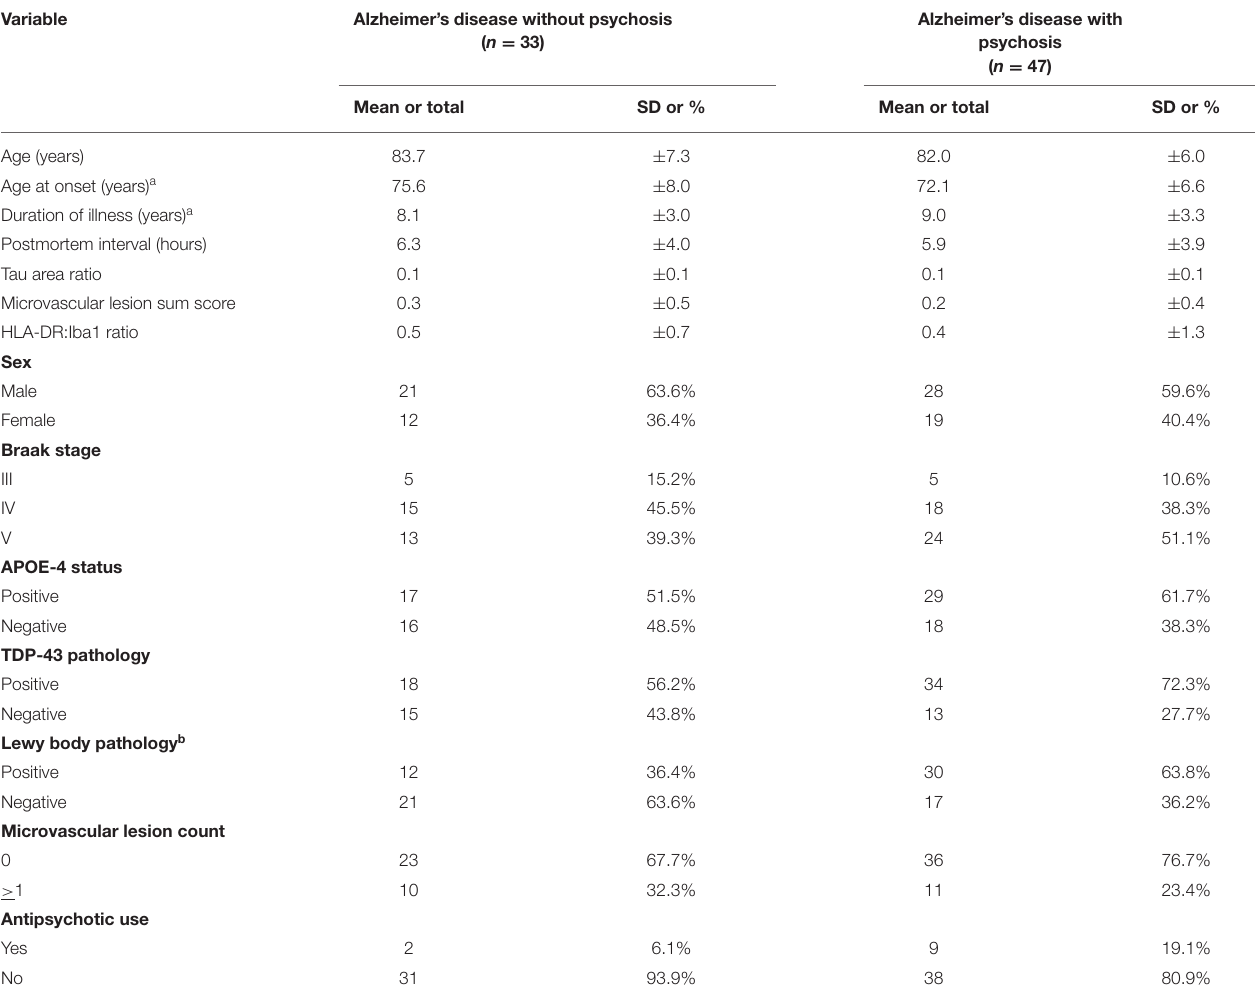
TABLE 1 | Demographic, clinical, and tissue characteristics of subjects with Alzheimer’s disease with and without psychosis examined by RNA-sequencing.